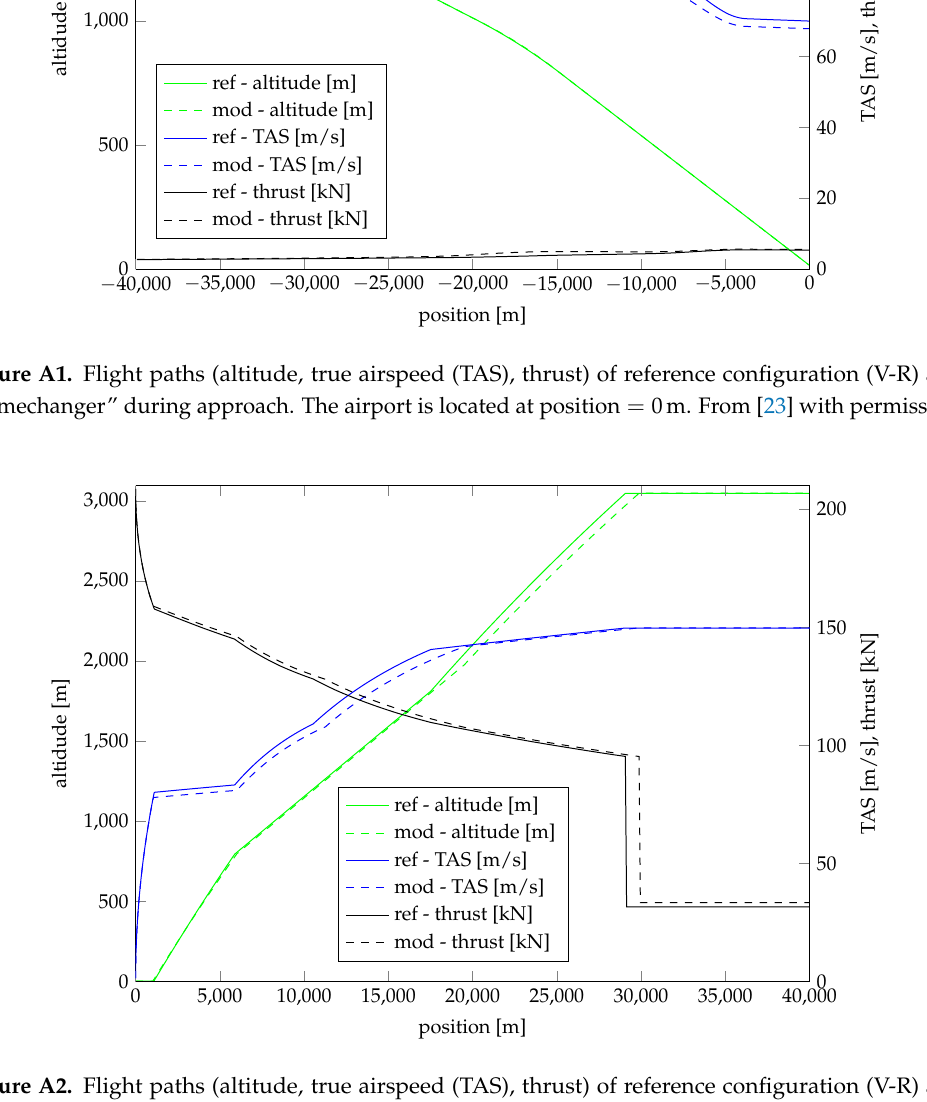
Figure A2. Flight paths (altitude, true airspeed (TAS), thrust) of reference configuration (V-R) and “gamechanger” during departure. The airport is located at position = 0m. From [23] with permission. Note the thrust reduction at the end of climb at position ≈